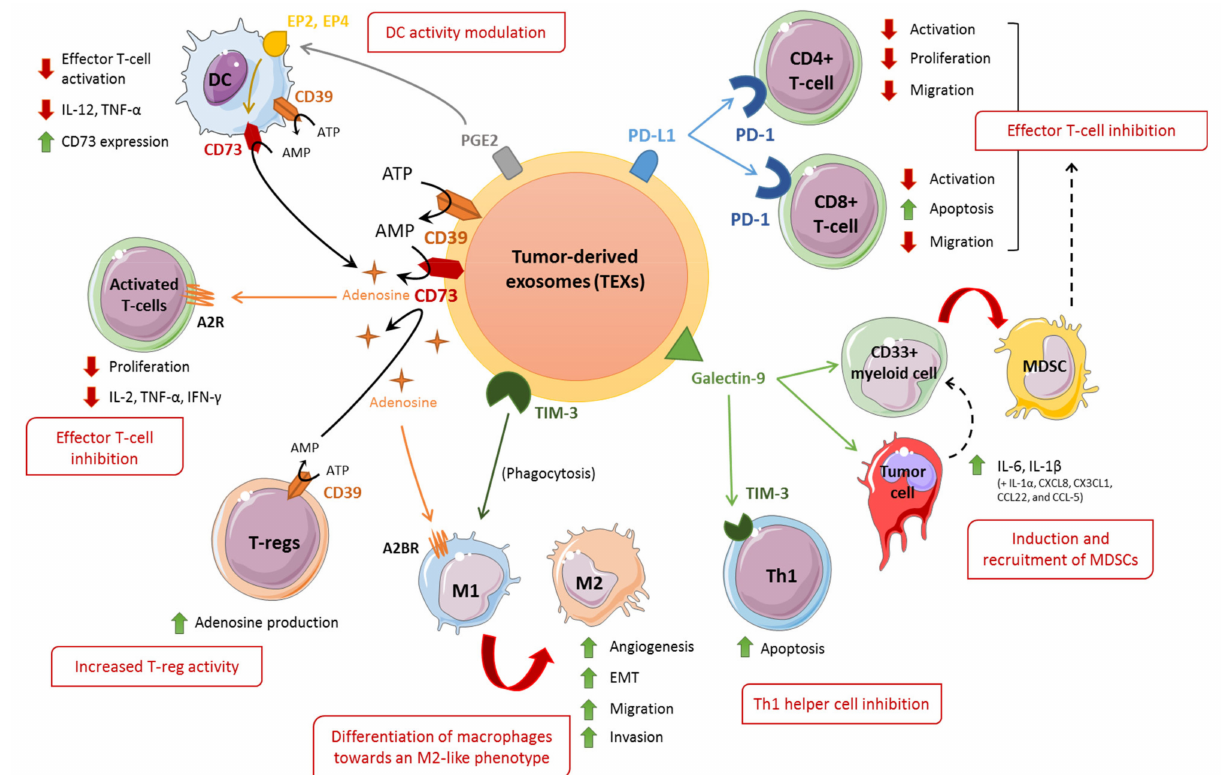
Figure 2. Potential immunosuppressive mechanisms of TEX in the context of immunotherapy resistance. TEX-bound CD73/CD39 can turn extracellular ATP into adenosine. Adenosine is a molecule possessing immunosuppressive properties in the TME. Adenosine binding to adenosine receptors (A2R, A2BR) on T-cells can directly inhibit T-cell activation. Adenosine also promotes differentiation of macrophages toward an M2-like phenotype. Prostaglandin E2 (PGE2)-containing TEX can also stimulate production of CD73 and subsequently adenosine by DCs, by activating PGE2 receptors (EP2, EP4). This results in an additional adenosine production. Moreover, TEX-bound TIM-3, upon phagocytosis by macrophages, can promote transition of the latter to a pro-tumoral M2-like phenotype. TEX-bound galectin-9 can promote apoptosis of T-helper cells (Th1) by binding to TIM-3 on the latter. TEX-bound galectin-9 can also promote the conversion of myeloid cells into tumor-favorable MDSCs by inducing the secretion of IL-6, IL-1 β , and other cytokines by nasopharyngeal carcinoma cells and myeloid cells. Additionally, TEX-bound PD-L1 can inhibit activation, proliferation, and migration of effector T-cells such as CD4 + and CD8 +